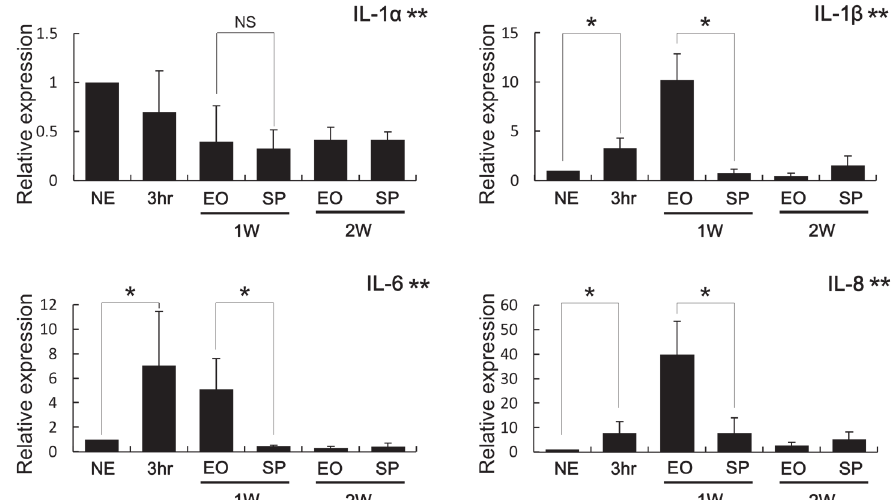
Figure 6- Expression of interleukins related to non-canonical osteoclastogenesis. Expression levels of IL-1β, IL-6 and IL-8 were significantly higher in the EO group than in the SP group 1 week after tooth extraction (1W). While IL-1 α expression level decreased after the extraction, the levels of EO and SP were similar at 1 week and 2 weeks (1W, 2W). NE: no extraction; EO: extraction only; SP: extraction and socket preservation; NS: non-significant; *: p<0.05 in paired t-test; **: p<0.05 in